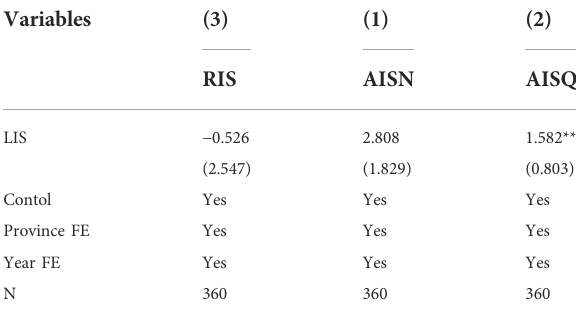
Table 6). This paper fi nds that the sign and signi fi cance of core explanatory variables remain unaffected by signi fi cant changes,